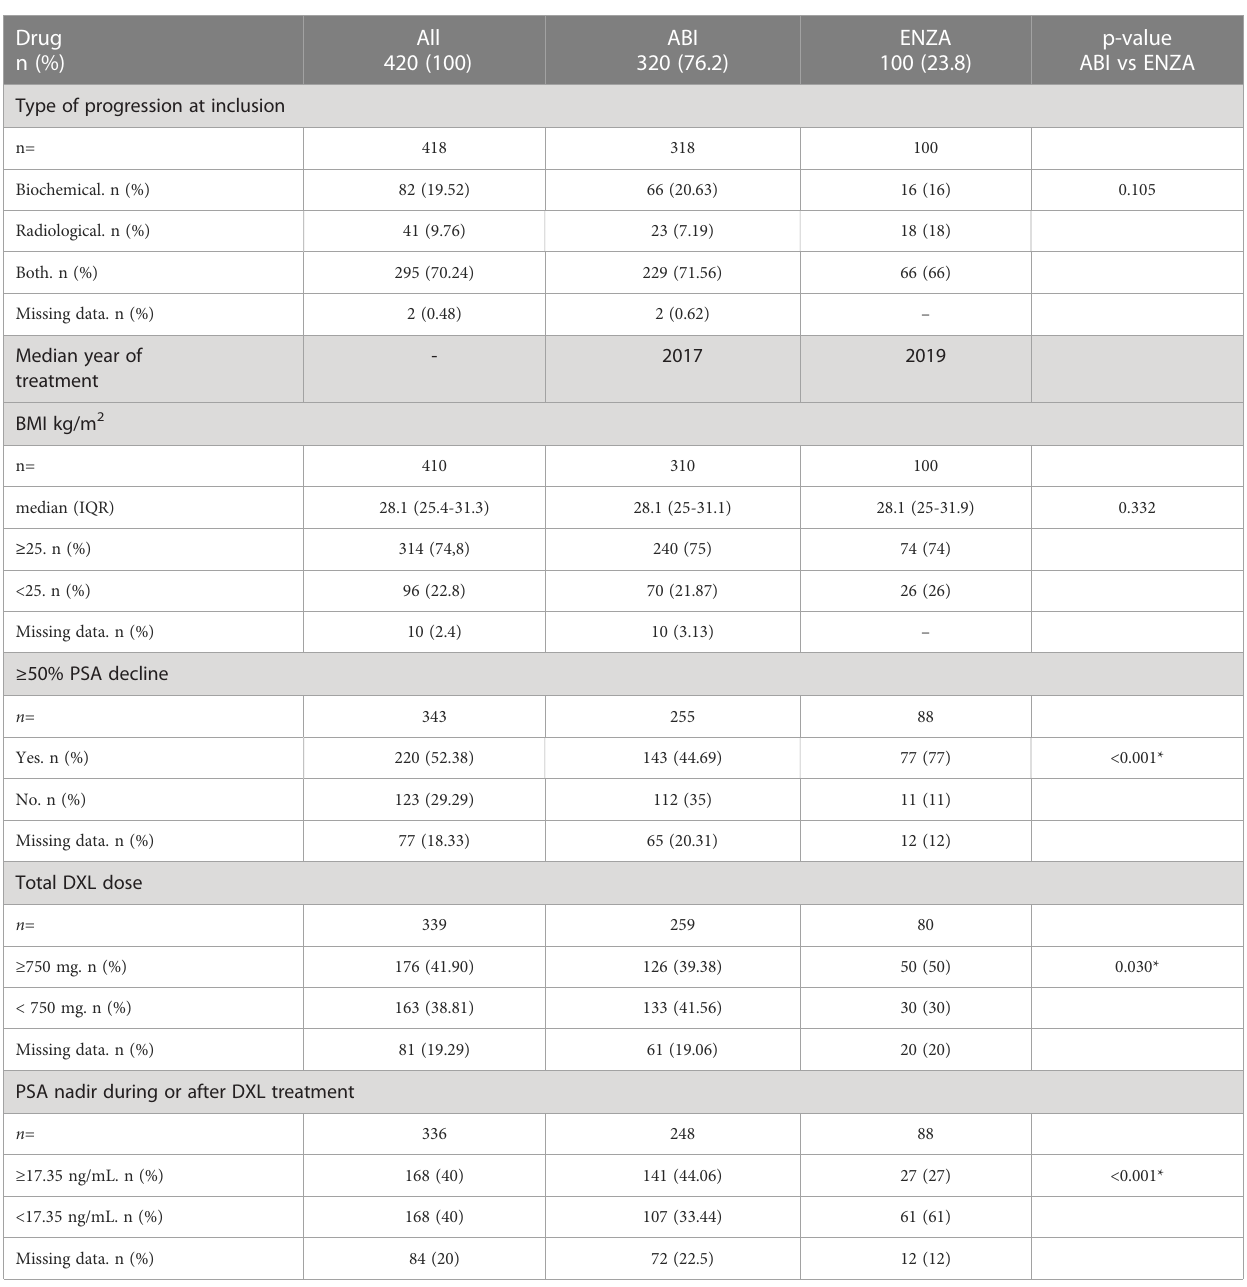
who were quali fi ed for ABI/ENZA therapy with concurrent biochemical and radiological progression had shorter median TTF than patients who experienced the single type of progression (8.8 vs. 10.8 mo.; p